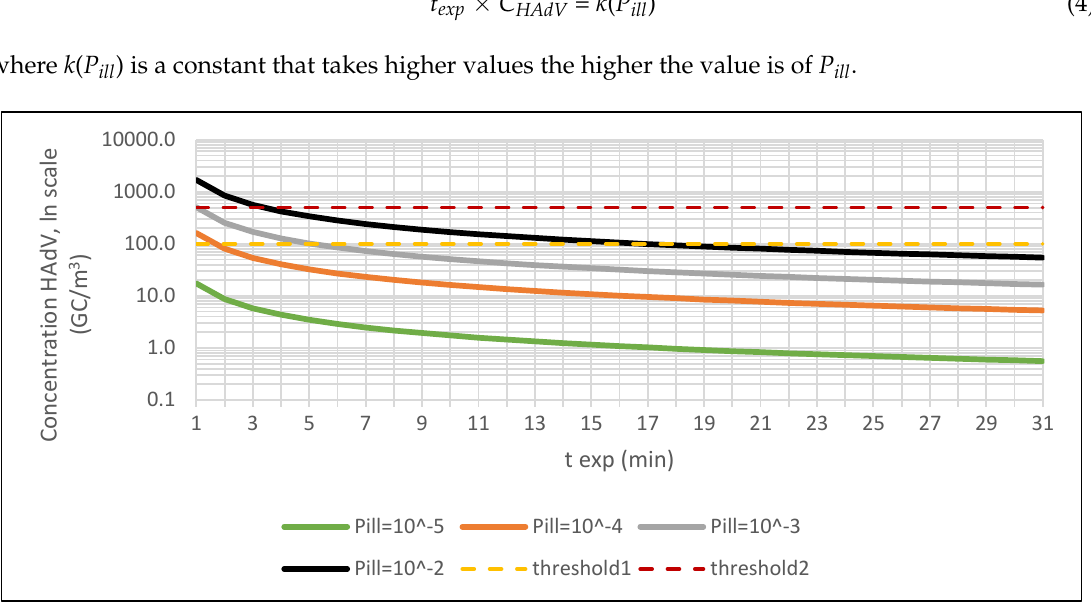
Figure 5. Iso-probability illness curves obtained for different combinations of exposure time and concentration of HAdV (threshold1 and threshold2 are examples of HAdV concentrations).